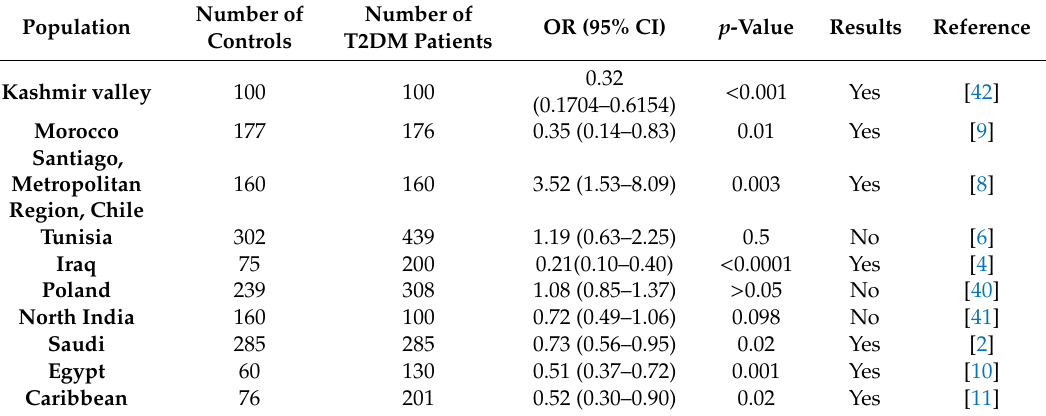
Table 10. List of studies on the FokI polymorphism and T2DM in di ff erent